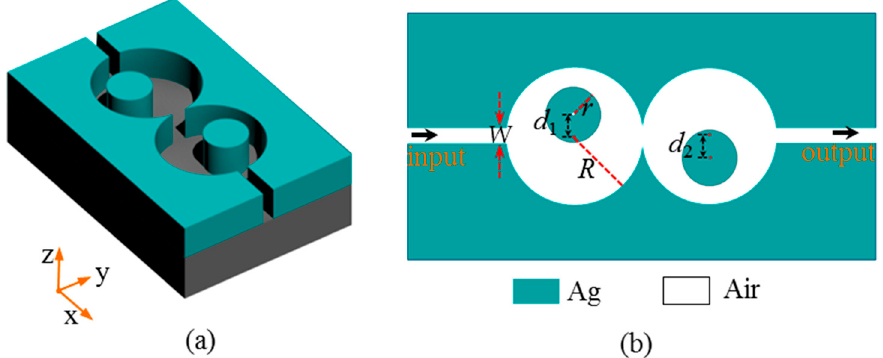
Figure 1. ( a ) A metal-insulator-metal (MIM) nanostructure composed of a main waveguide and two cascaded asymmetric cavities at the center; ( b ) the corresponding cross section of the structure where the left and right metal cores of the cavities shift along + y and − y -axis directions with distances of d 1 and d 2 , respectively.